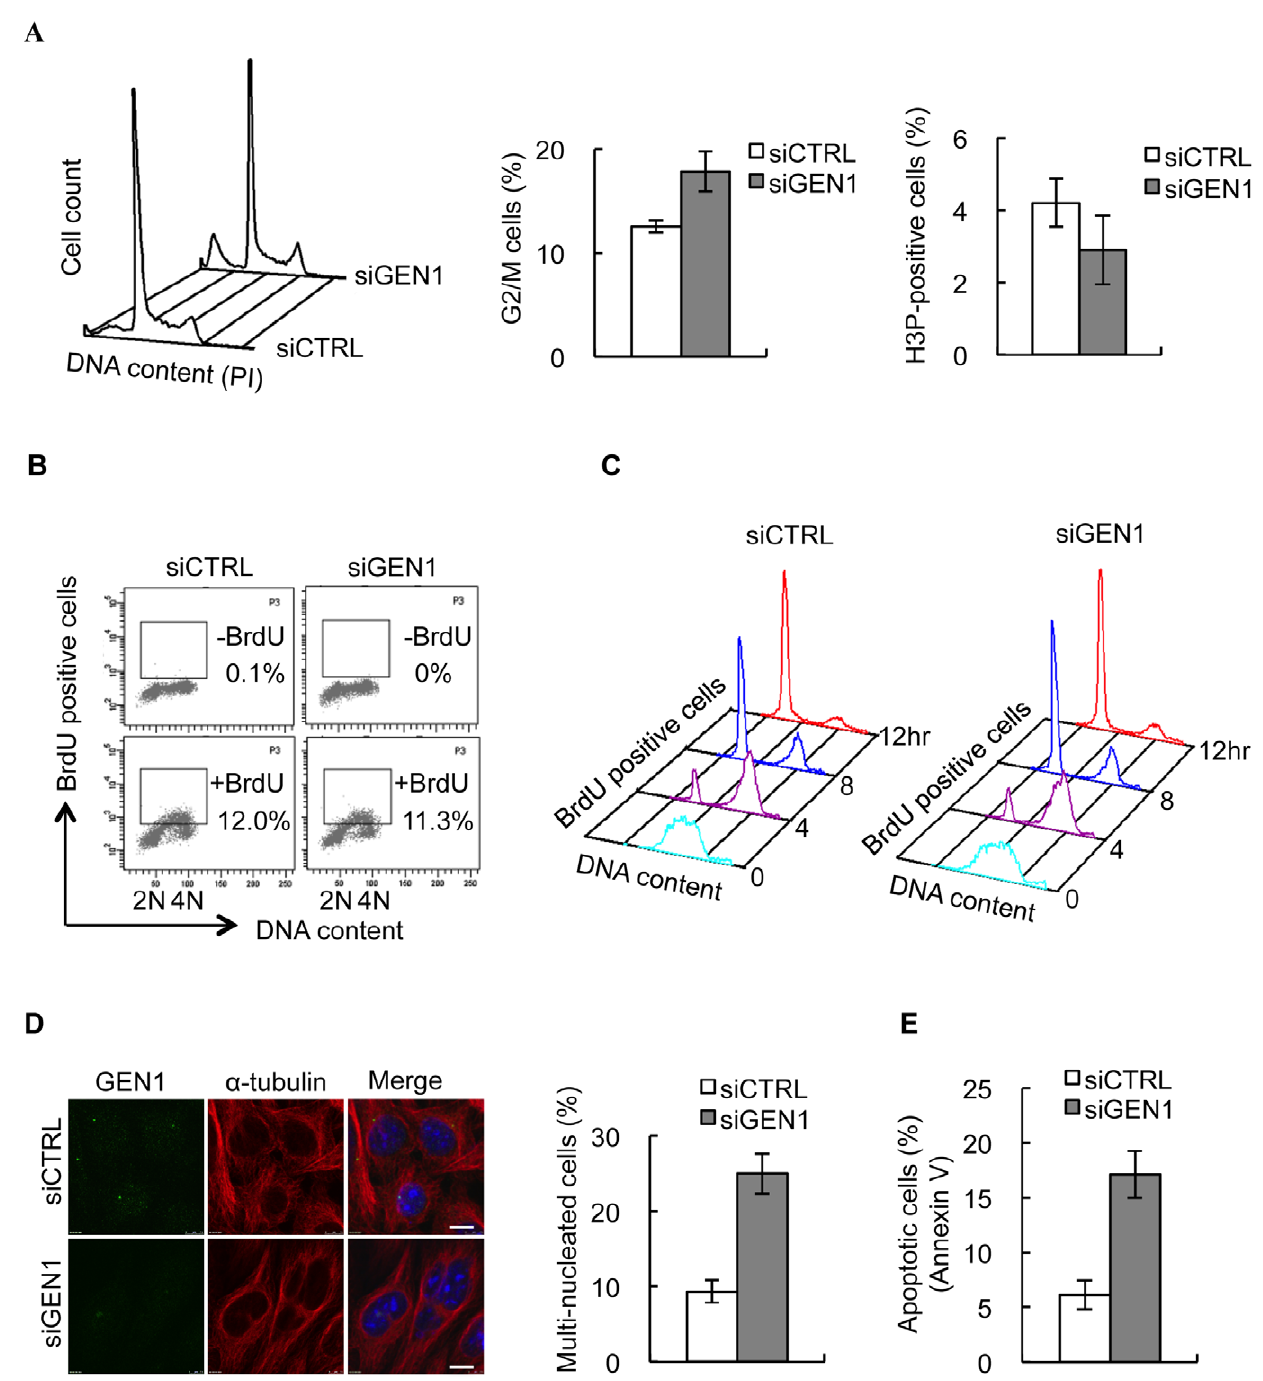
Figure 4. GEN1 depletion interferes with cell cycle progression and results in multi-nucleation and apoptosis. A. (left) 293T cells were treated with CTRL or GEN1 siRNA for 48 h stained with propidium iodine (PI) and analyzed by flow cytometry. (middle) G2/M cells were identified using Modfit software. (right) Mitotic cells were detected by phospho H3 antibody staining followed by flow cytometric analysis. Quantification is based on three independent experiments. Error bars indicate S.E.M. B. Hela cells were treated with CTRL or GEN1 siRNA for 48 h, labeled with or without 10 uM BrdU for 2 hours, stained with FITC conjugated anti-BrdU antibodies and propidium iodine (PI), and analyzed by flow cytometry. x- axis: propidium iodine (PI). y-axis FITC. C. CTRL or GEN1 siRNA treated Hela cells were incubated with 10 uM BrdU for 2 hours, and return to BrdU-free medium for the indicated times. Cell cycle progression of BrdU labeled cells were analyzed by flow cytometry. D. HeLa cells treated with CTRL or GEN1 siRNA (48 h) were methanol fixed and immunostained with GEN1(anti-GEN1 (651–892aa) antibody) and a -tubulin. DNA was visualized by DAPI. (Right) Graph represents the mean of three independent experiments. (n=100 cells/condition/experiment). Error bars indicate S.E.M. E. HeLa cells were treated with CTRL or GEN1 siRNA for 48 h fixed, stained with annexin V and analyzed by flow cytometry. Quantification was based on three independent experiments. Error bars indicate S.E.M.